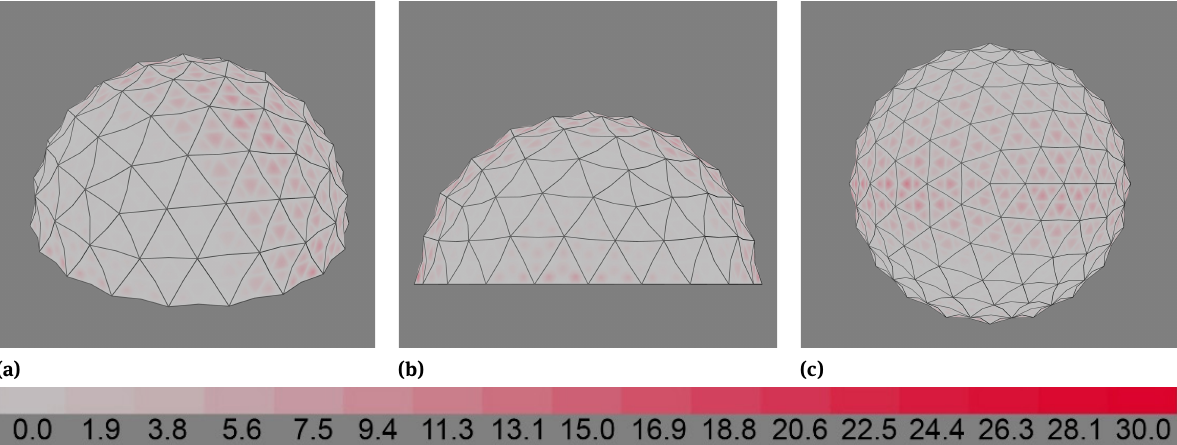
Figure 17: Fabric under the wind load (0.39 kN/m 2 ). a) 3D view, b) Side view, c) Top view. Maximum displacement: 12.52 cm